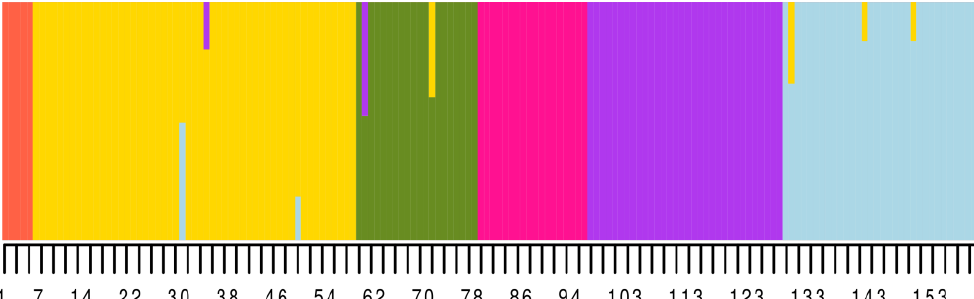
Figure 4. Ancestry matrix constructed for six white lupin subpopulations ( n = 160). Plants in these subpopulations showed the following mean values of number of days from sowing to flowering: V1, 64.5 ± 9.5 days; V2, 62.8 ± 12.0; V3, 57.7 ± 9.0; V4, 54.9 ± 10.8; V5, 53.9 ± 8.9; and V6, 55.8 ± 11.5 days. There were significant differences between years ( p -value < 2 × 10 − 16 ) and groups ( p -value 3.7 × 10 − 11 ) and no significant interaction between years and groups ( p -value 0.996) (Figure